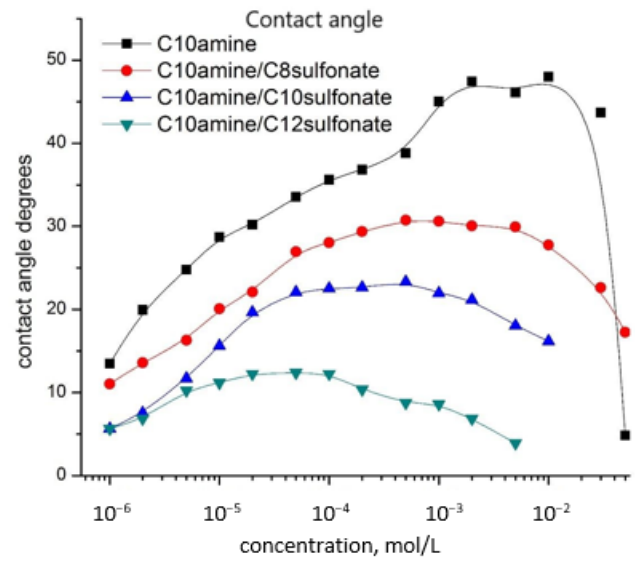
Figure 3. Measure of the contact angle vs. the C 10 amine concentration for different systems [55] . Reprinted from Ref. [55] with permission. Copyright Elsevier 2009.